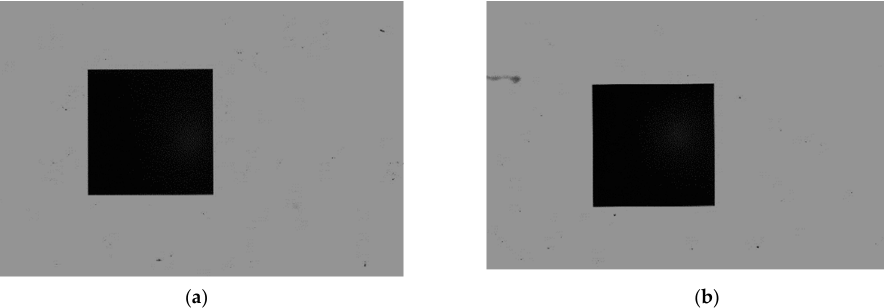
Figure 11. Images captured by the left and right camera. ( a ) The image captured by the left camera. ( b ) The image captured by the right camera.